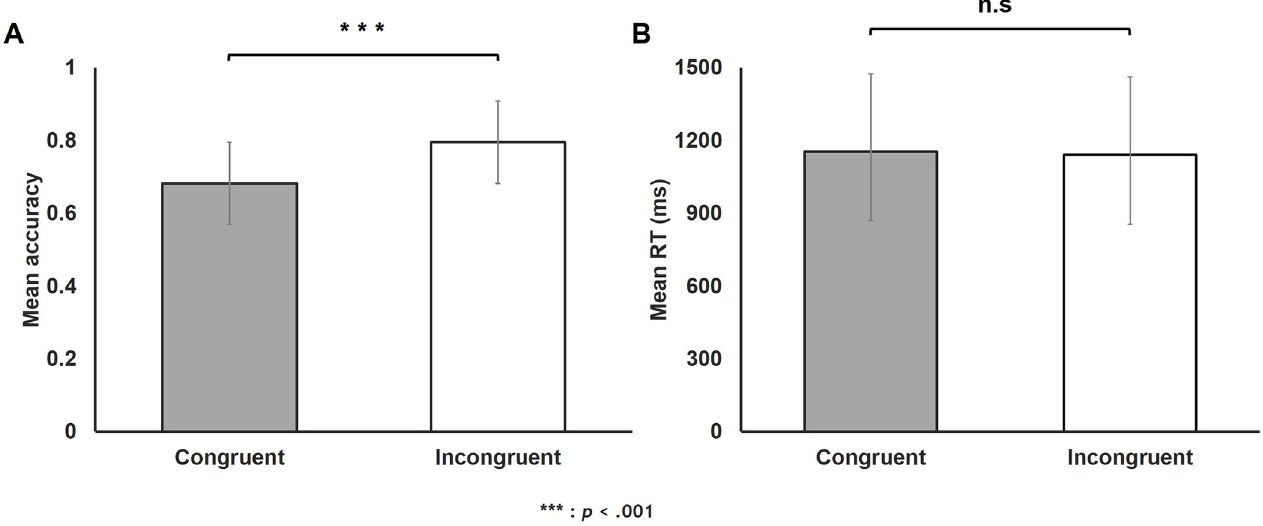
Fig 3. Results of dependent samples t -tests on mean (A) accuracy and (B) RT from the Numerosity Comparison task. Accuracy (but not RT) was significantly higher in the Incongruent compared to the Congruent condition manifesting a reverse congruency effect. Error bars represent standard errors of the mean.